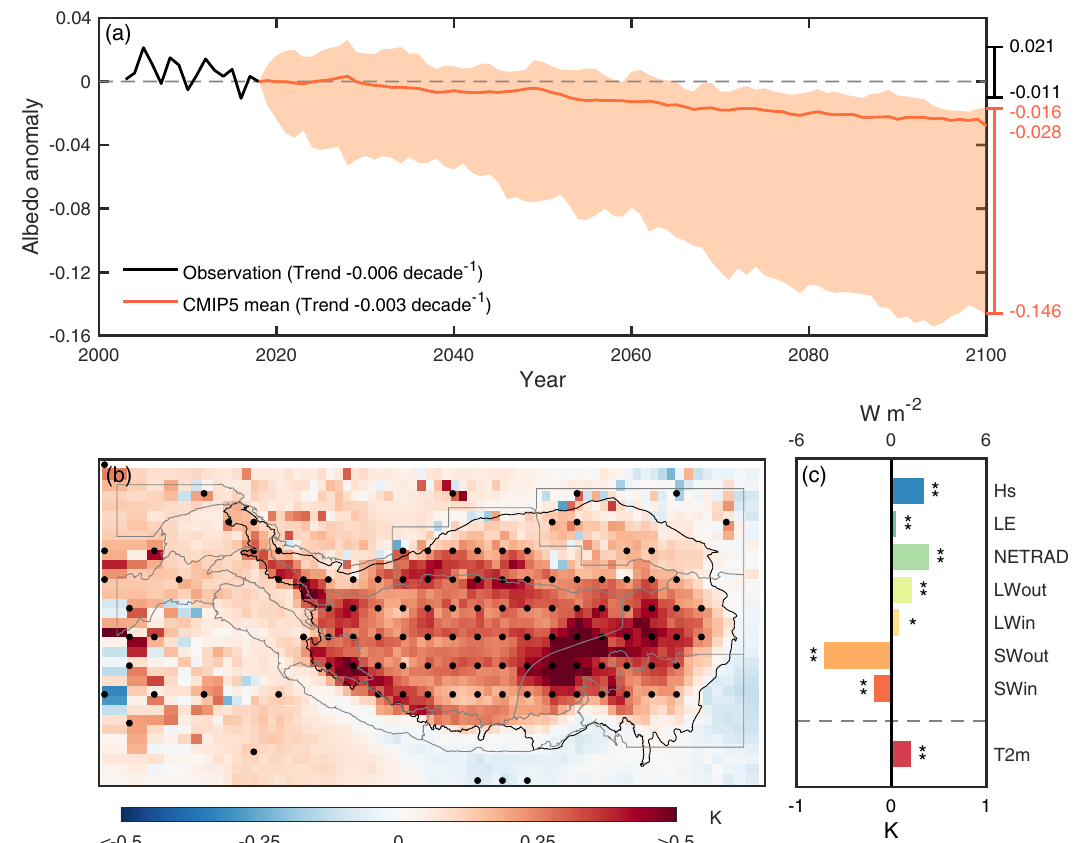
Fig. 1 | Changes of albedo and albedo-induced local climate in the Tibetan Plateau(TP).a Time series of albedoanomaly in the TP.The thick solidblack line represents the albedo anomaly of observation during 2003-2018 CE, which is the annual mean albedo derived from the MODIS MCD43 product relative to its benchmark-year (2018 CE) value. The thick solid orange line and shaded orange area, respectively, represent the weighted average and ranges of future (2018- 2100 CE) projection albedo anomaly derived from 35 global climate models (GCMs)inCMIP5.ThefutureprojectionalbedoanomalyderivedfromeachCMIP5 GCMisthe5-yearmovingaverageoftheannualmeanalbedoinRCP8.5relativeto its benchmark-year (2018 CE) value. Trends of the thick solid black and orange lines are about − 0.006 decade − 1 ( p =0.19, Mann-Kendall test) and about − 0.003 decade − 1 ( p <0.01, Mann-Kendall test), respectively. b The spatial pattern of the